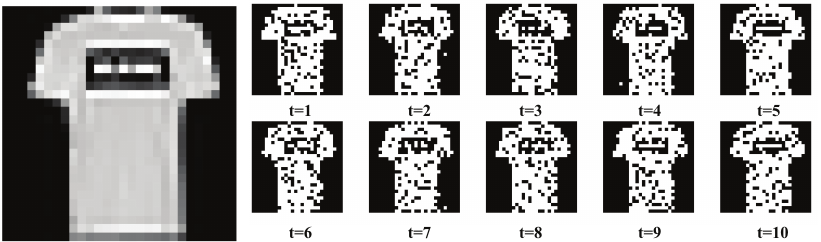
Figure 3. An image of Fashion-MNIST [30] dataset is presented in the form of Poisson-distributed spike